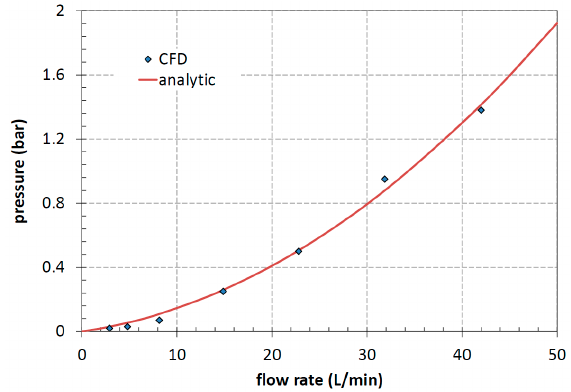
Figure 14. Spring chamber pressure vs. flow rate: fitting of CFD values with 2nd order polynomial.